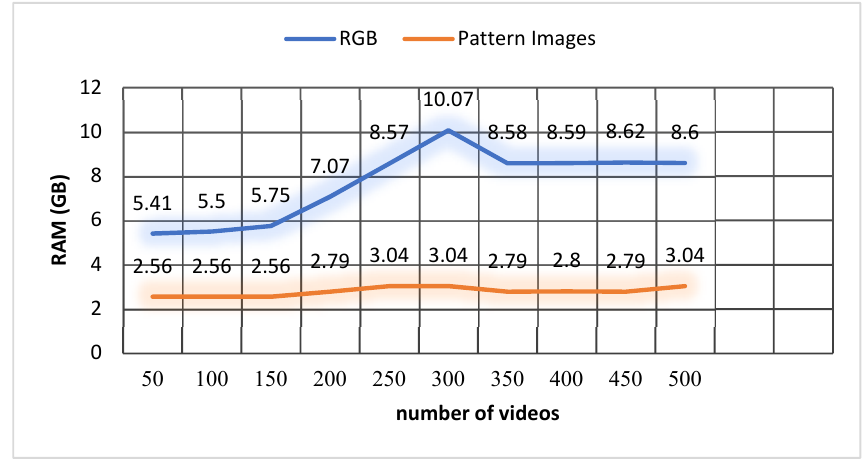
Figure 8. Actual Memory (RAM) Utilization as the number of videos increase.